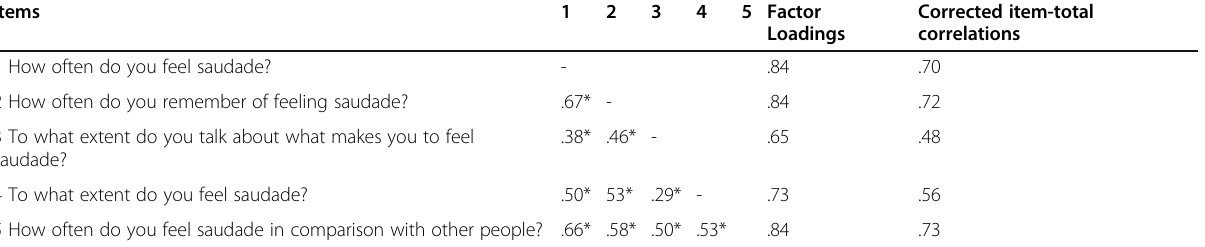
Table 2 PSS items, intercorrelations among the items, structure coefficients, and item-reminder correlations Items 1 2